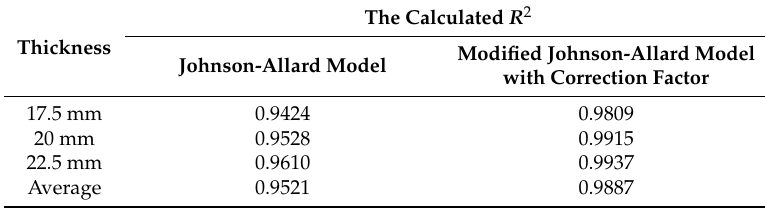
Table 2. The summarized R 2 for comparisons of prediction accuracy of the model.